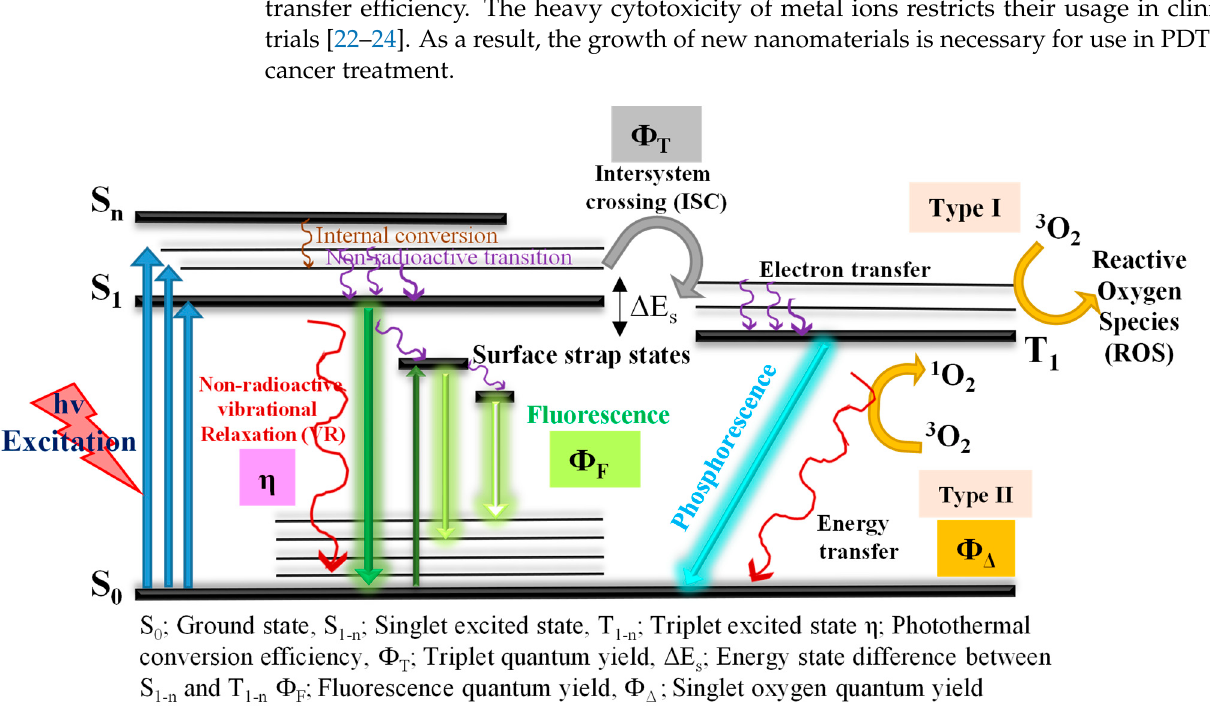
Figure 1. The mechanisms of photodynamic therapy.